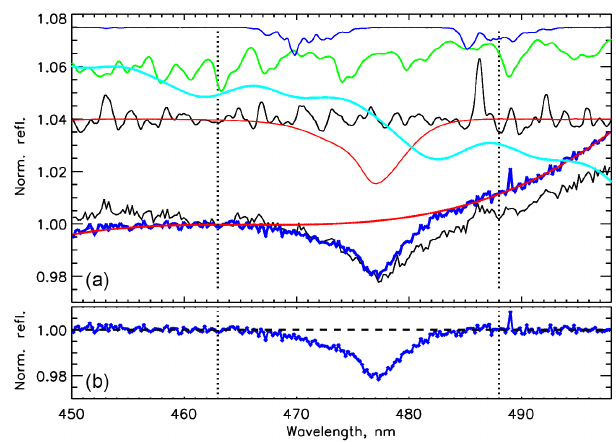
Figure 3. Similar to Fig. 2 but for row 44 and orbital scan num- ber iTime = 1315 pointing to the Beijing area. In (a) , the thick blue line follows the reflectances after removal of the trace-gas (O 3 and H 2 O) absorption, however with the Ring spectrum features remain- ing intact. This is to be compared to the adjacent black line that follows the original reflectances. Panel (b) shows the normalized O 2 -O 2 profile as used in the SCD retrieval.